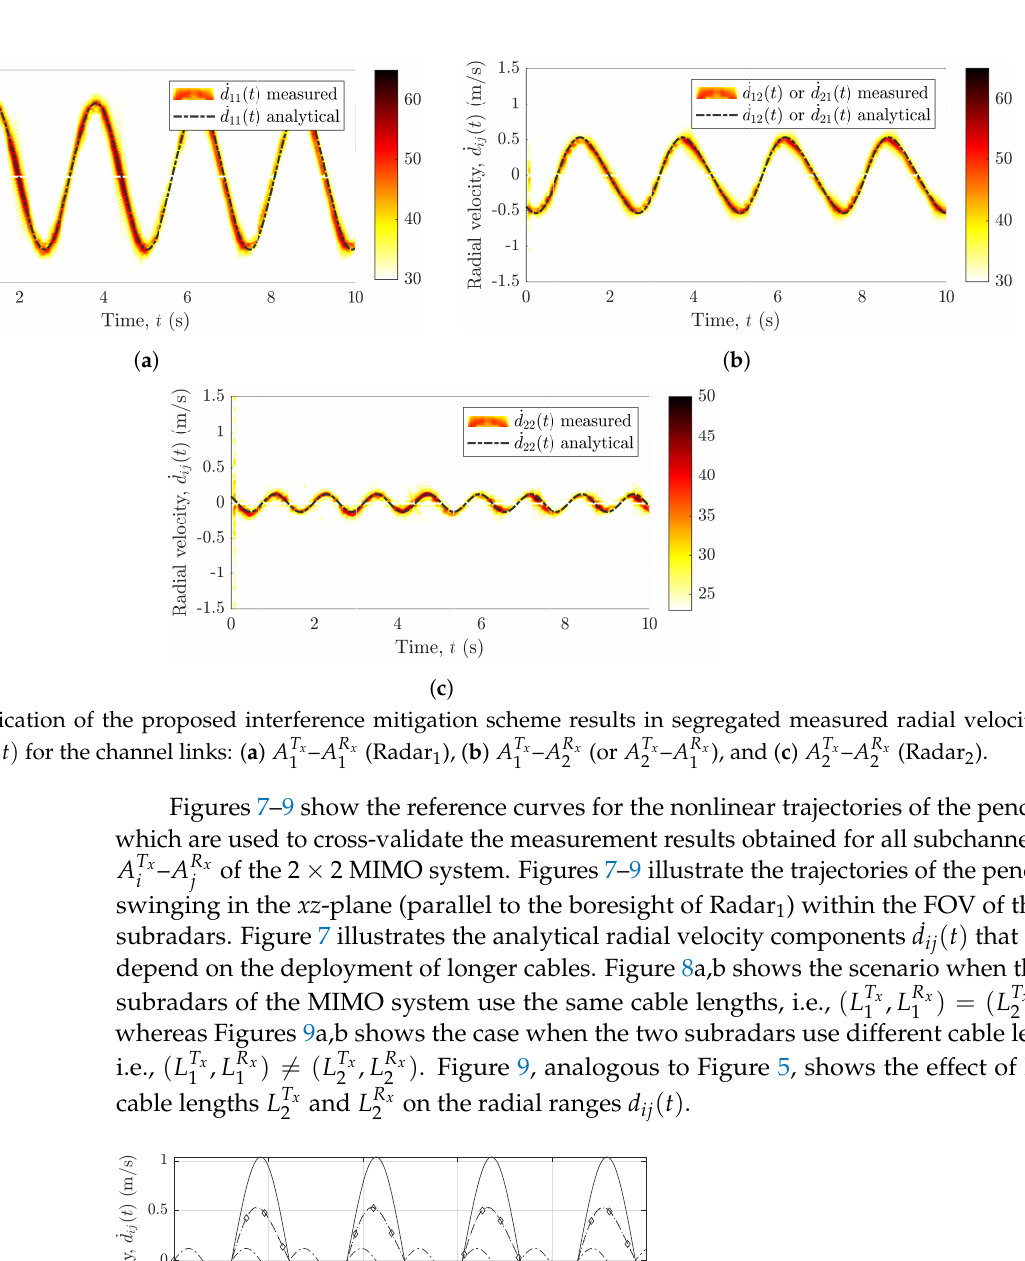
– A R x , A T x – A R x 2 1 1 1